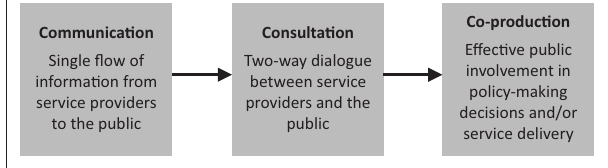
FIGURE 2: Public participation